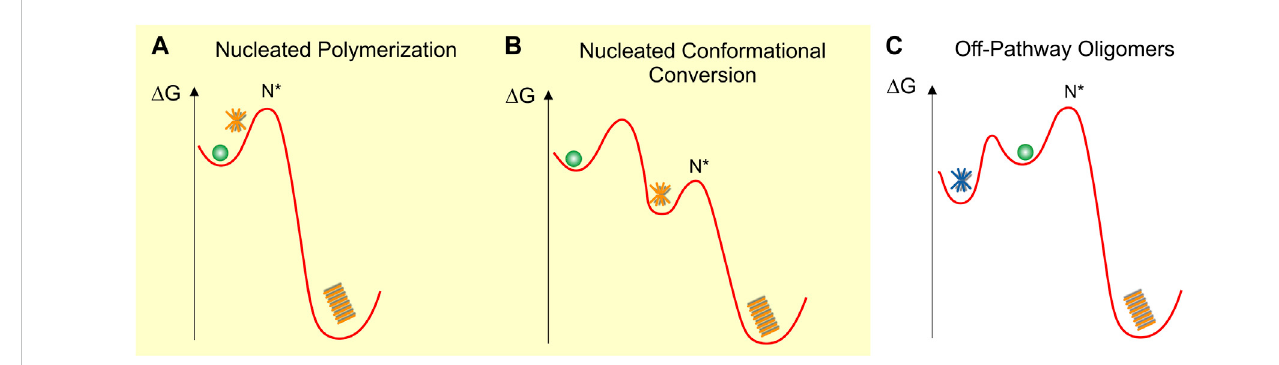
FIGURE 1 Schematicfee-energy landscapes for oligomer formation (A) On-pathwayNucleatedPolymerization or NP, (B) On-pathwayNucleatedConformational Conversion or NCC (C) Off-pathway oligomer formation. Oligomers are indicated as orange (on-pathway) or blue (off-pathway) stars and fi brils as orange stacks.N*indicatesthecritical fi brilnucleusatthepeakoftheenergybarrier Δ G f for fi